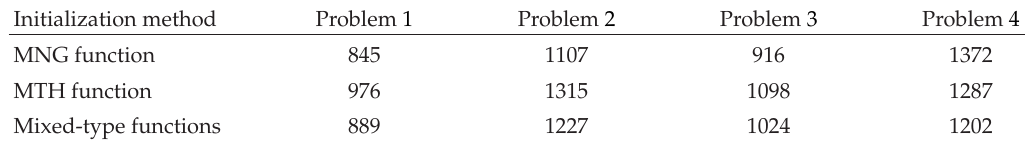
Table 8: Convergence speed of the CGA using di ff erent initialization